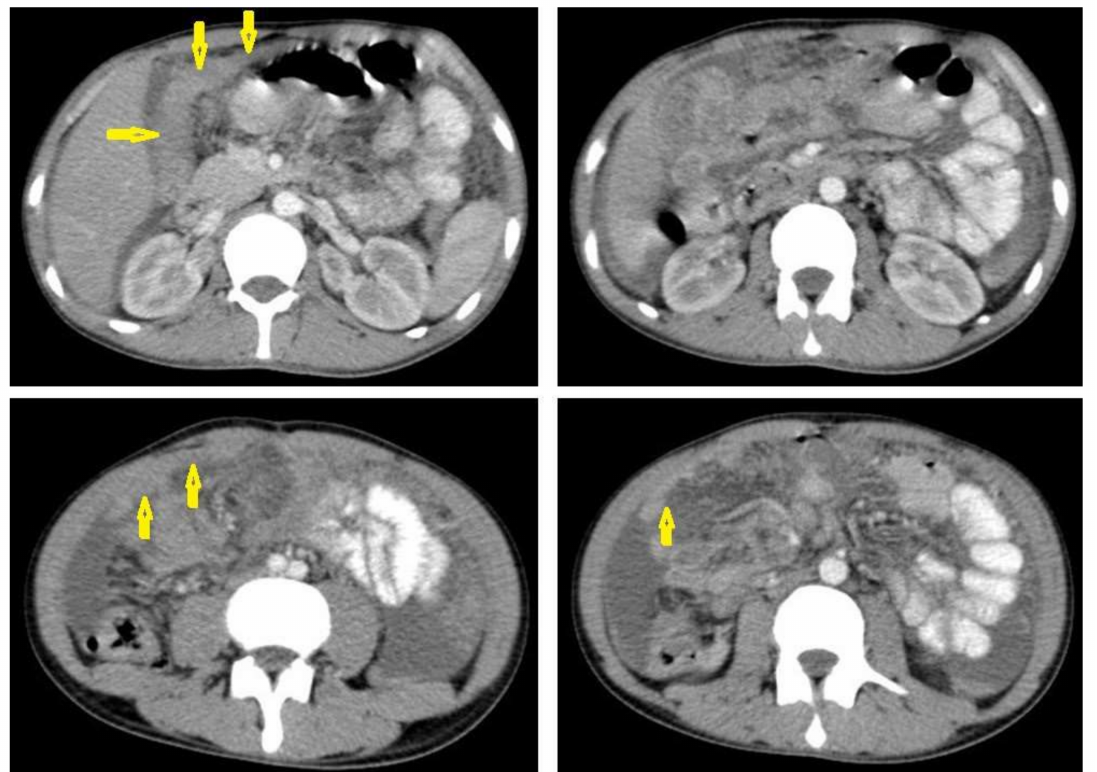
Figure 22. Fibrotic peritonitis in a 20-year-old man with fatigue, abdominal distension, and loss of appetite. Selected axial images of abdominal CT show remarkable omental thickening, forming cake- like masses (arrows) with faint enhancement and mild smooth thickening of peritoneal reflections associated with mild-to-moderate dense ascites and several low-attenuation mesenteric lymph nodes that are challenging to be distinguished from small bowel